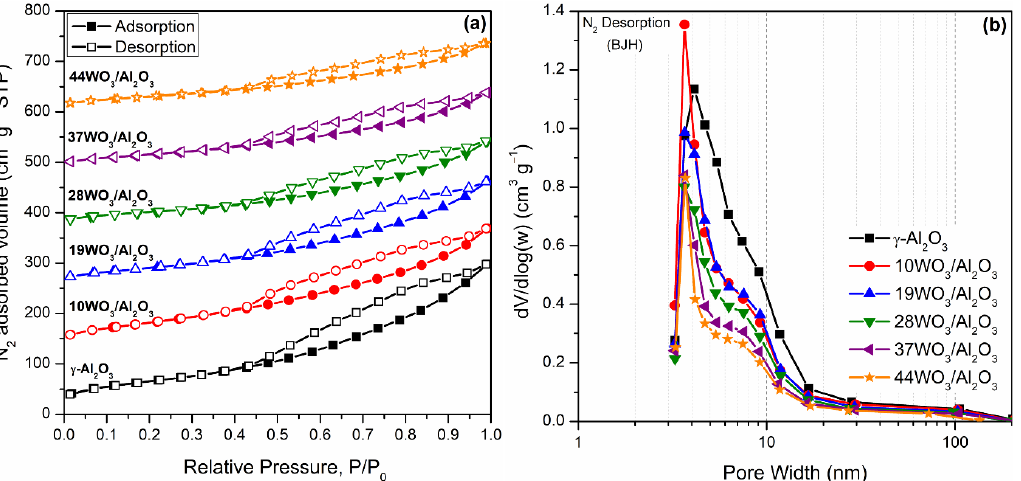
Figure 1. N 2 adsorption–desorption isotherms ( a ) and pore size distribution ( b ) of WO 3 /Al 2 O 3 catalysts. Isotherms in ( a ) are shifted vertically for clarity. Table 1. Tungsten surface density, textural properties and number of acid sites, total and